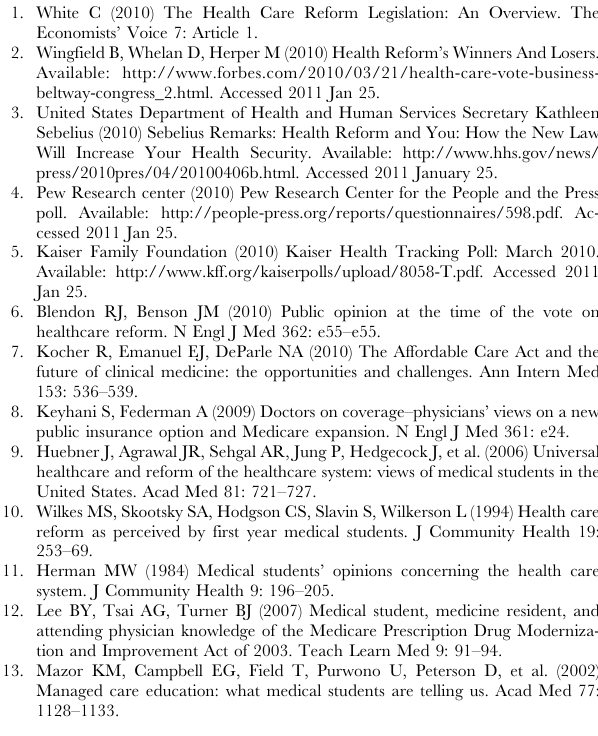
Table 31: Total Active Enrollment by U.S. Medical School and Race and Ethnicity, 2010. Available: https://www.aamc.org/download/160146/data/ table31-new-enrll-raceeth-sch-2010-web.pdf.pdf. Accessed 2011 Jan 25. 17. AAMC (2010) AAMC: Data Warehouse: STUDENT file as of 10/26/2010, Table 26: Total Active Enrollment by U.S. Medical School and Sex, 2006–2010. Available: https://www.aamc.org/download/158818/data/table26-factsenrll Table 28: Total U.S. Medical School Enrollment by Race and Ethnicity within Sex, 2002–2010. Available: https://www.aamc.org/download/158404/data/ table28-enrllbyraceeth0210.pdf.pdf. Accessed 2011 Jan 25. 19. AAMC (2010) AAMC: DW: STUDENT file as of 11/9/2010, Table 36: